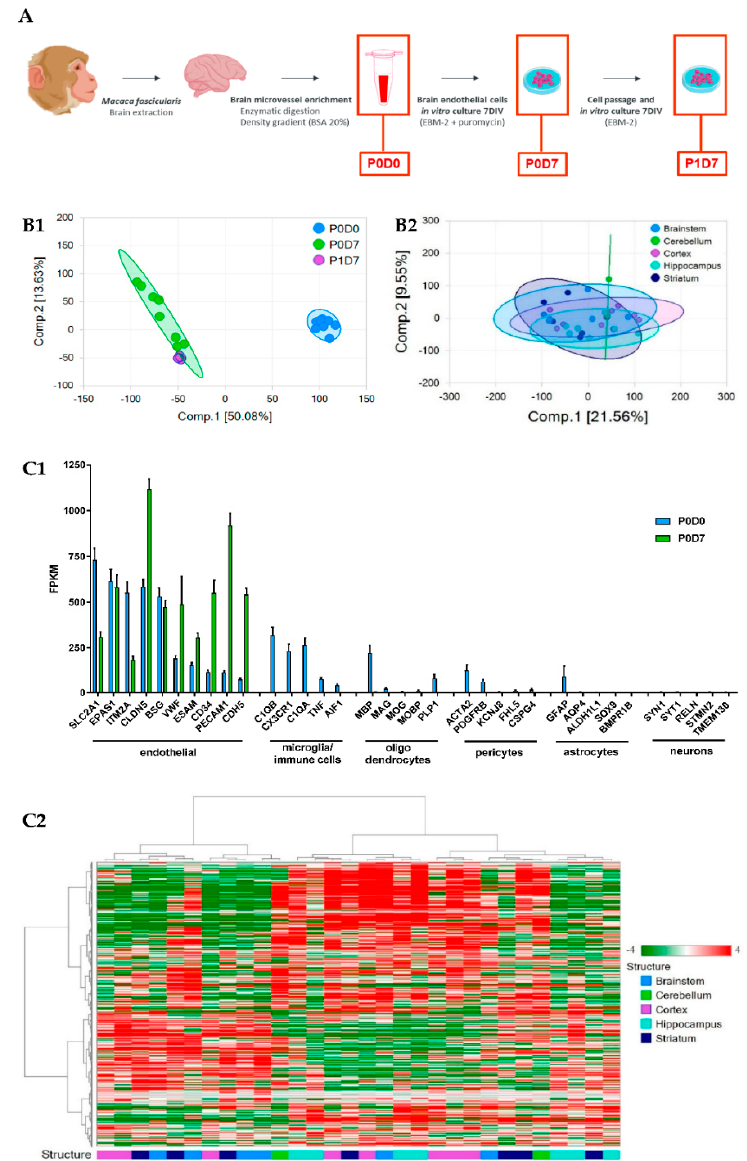
Figure 1. Brain endothelium transcriptome of samples prepared from non-human primates (NHP). ( A ) Diagram of the procedure conducted for the isolation of NHP-derived brain microvessels and in vitro selection of brain endothelial cells (BECs). ( B1 ) Principal Component Analysis (PCA) of brain cortical microvascular samples clustered in 3 groups (P0D0 n = 8, P0D7 n = 8, P1D7 n = 6). ( B2 ) PCA of brain endothelial samples clustered in 5 groups (cortex n = 8, brainstem n = 6, hippocampus n = 7, striatum n = 7, cerebellum n = 2). ( C1 ) Comparison of the expression levels of endothelial cell and non-endothelial cell markers in the brain microvascular P0D0 and P0D7 fractions. An expression threshold of one FPKM in at least half of the independent replicates (P0D0, n = 8; P0D7, n = 8; P1D7, n = 6; FPKM ≥ 1 in n ≥ 4 samples) was applied in order to consider only the di ff erentially expressed gene having a significant expression level. Gene levels of brain endothelial cell markers are enriched in P0D0 and P0D7 samples, and even though RNA levels of markers for microglia (or immune cells), oligodendrocytes, pericytes, astrocytes and neurons can be detected in P0D0 samples, their expression is o ff in P0D7. Results represent average FPKM and are expressed and mean ± SEM. ( C2 ) Hierarchical clustering of BECs from the selected brain structures showing a lack of clustering per brain structure. An expression threshold of one FPKM in at least 3 samples was applied to ECs derived from di ff erent regions (cortex n = 8, brainstem n = 6, hippocampus n = 7, striatum n = 7, cerebellum n = 2) for the analysis of di ff erentially expressed genes.